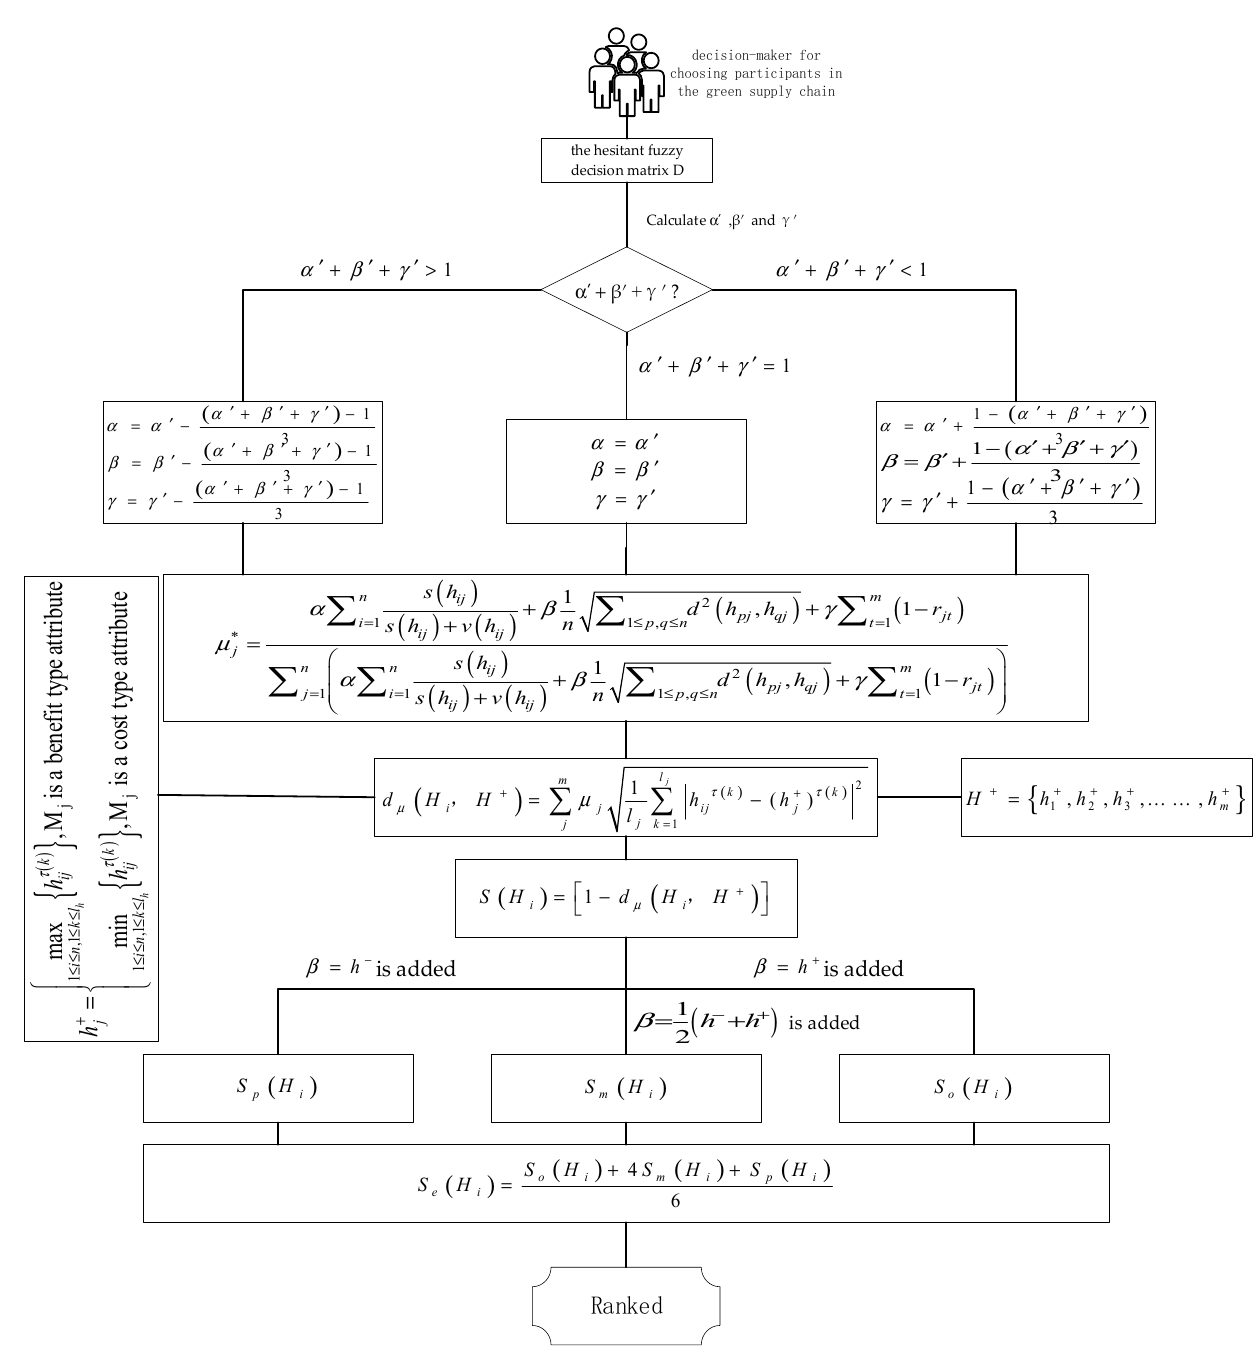
Figure 1 . Diagram of the decision-making method for green supply chain member selection. Figure 1. Diagram of the decision-making method for green supply chain member